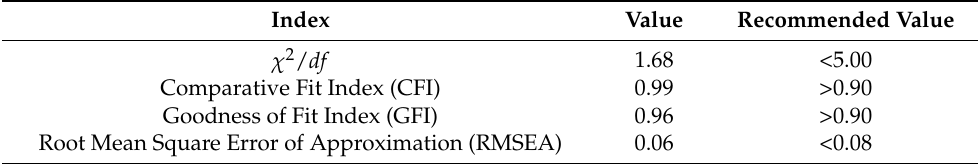
Table 5. Overall fitness of the proposed model and recommended values ( n = 218).